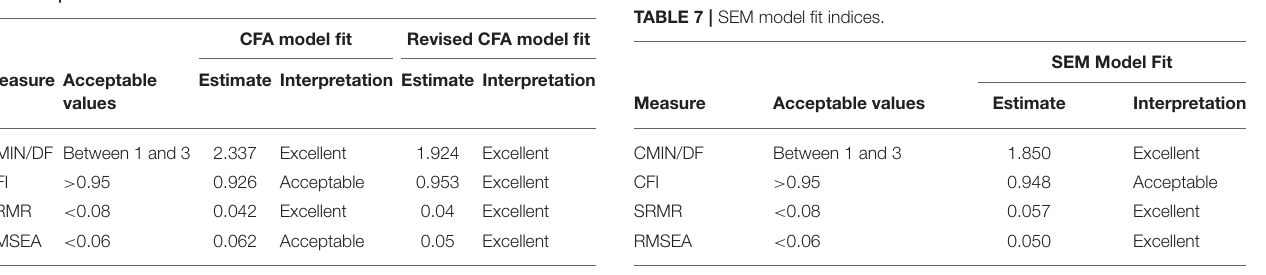
TABLE 5 | CFA model fit indices.